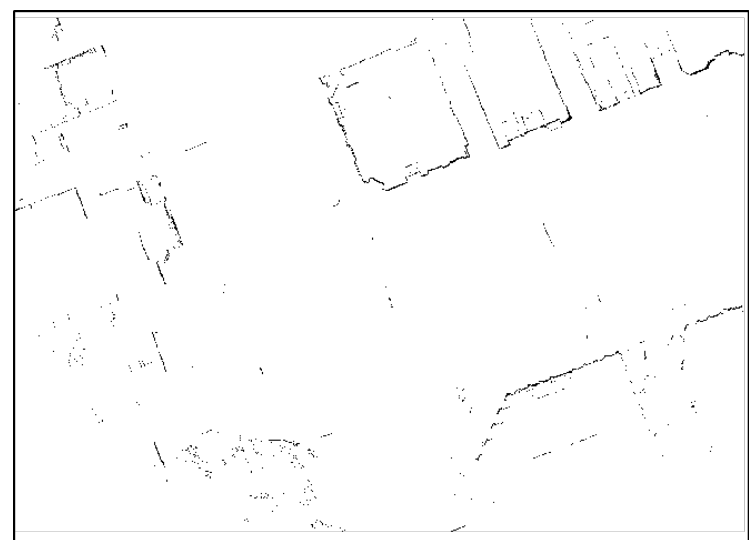
Figure 16. Generated occupancy grid map. Sensors 2018 , 16 , x FOR PEER REVIEW